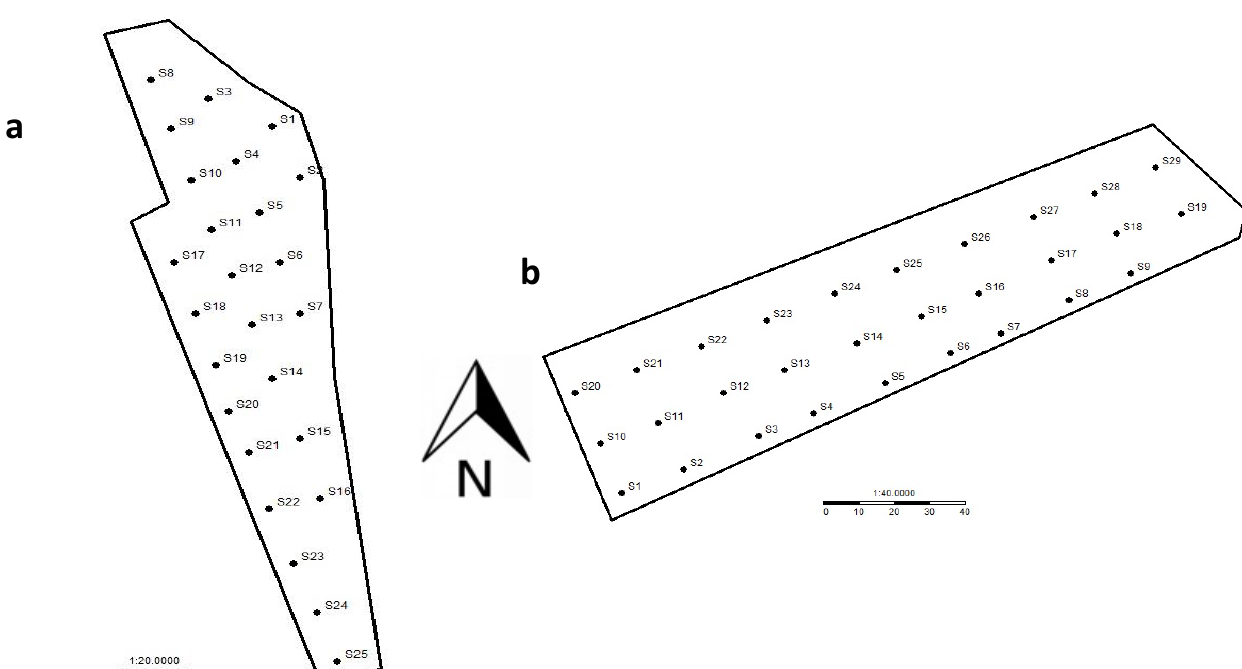
Figure 2. Measurement grids used in the experiment. The 25 grid sites for the slope plot ( a ) and 29 grid sites for flat plot ( b ). S i represents the sampling site number i .